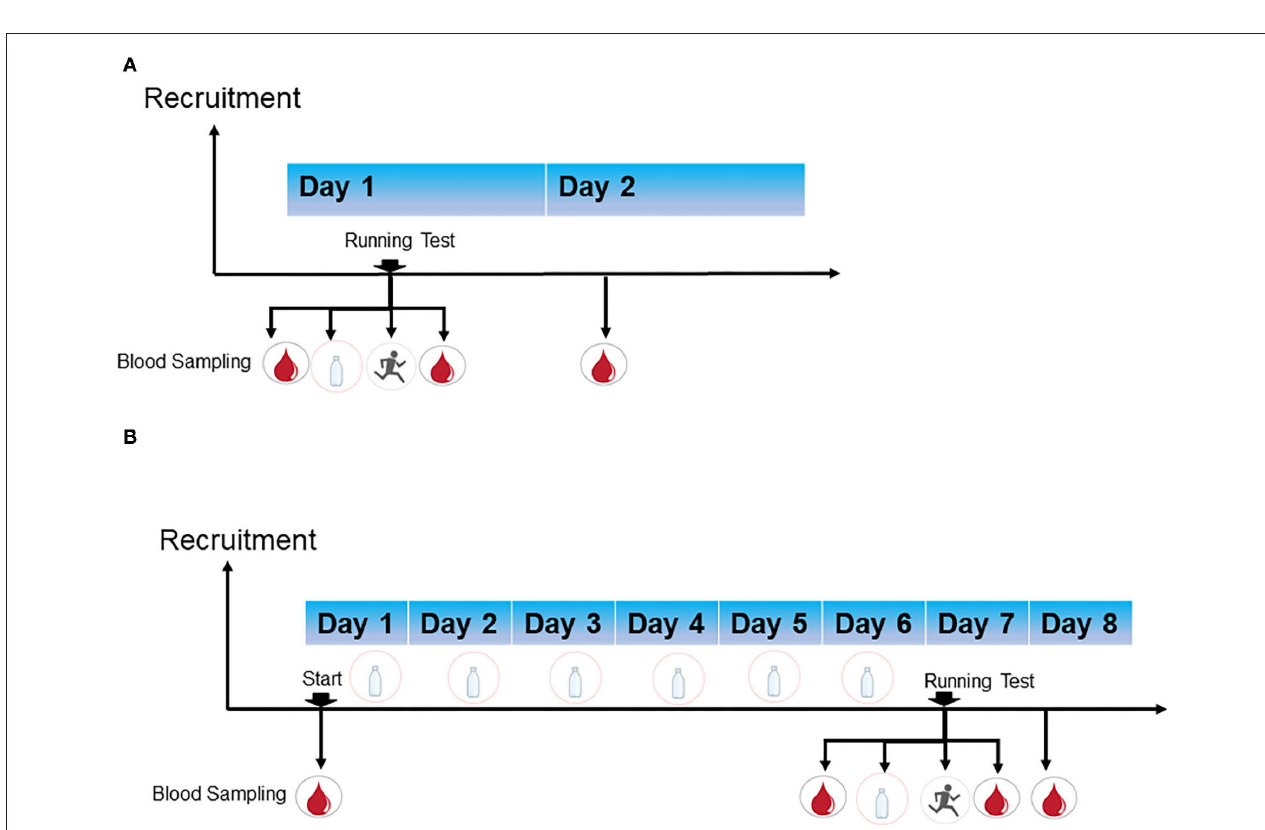
FIGURE 1 | Time scheme of the single-shot supplement trial (pilot trial) (A) and short-term supplement trial (B)